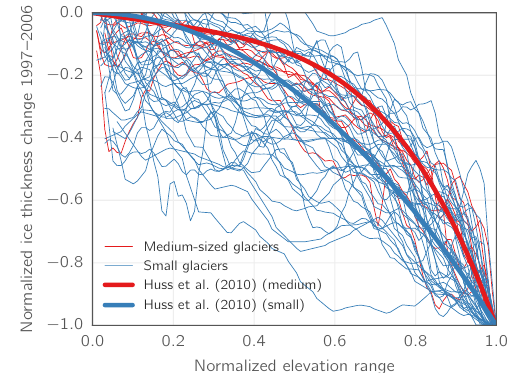
Figure 2. Normalized observed ice thickness change for 42 small ( A< 5km 2 , thin blue lines) and 8 medium-sized (5km 2 ≤ A< 20km 2 , thin red lines) glaciers in the Ötztal Alps dur- ing the period 1997–2006 and the corresponding parameterizations from Huss et al. (2010) (thick lines).